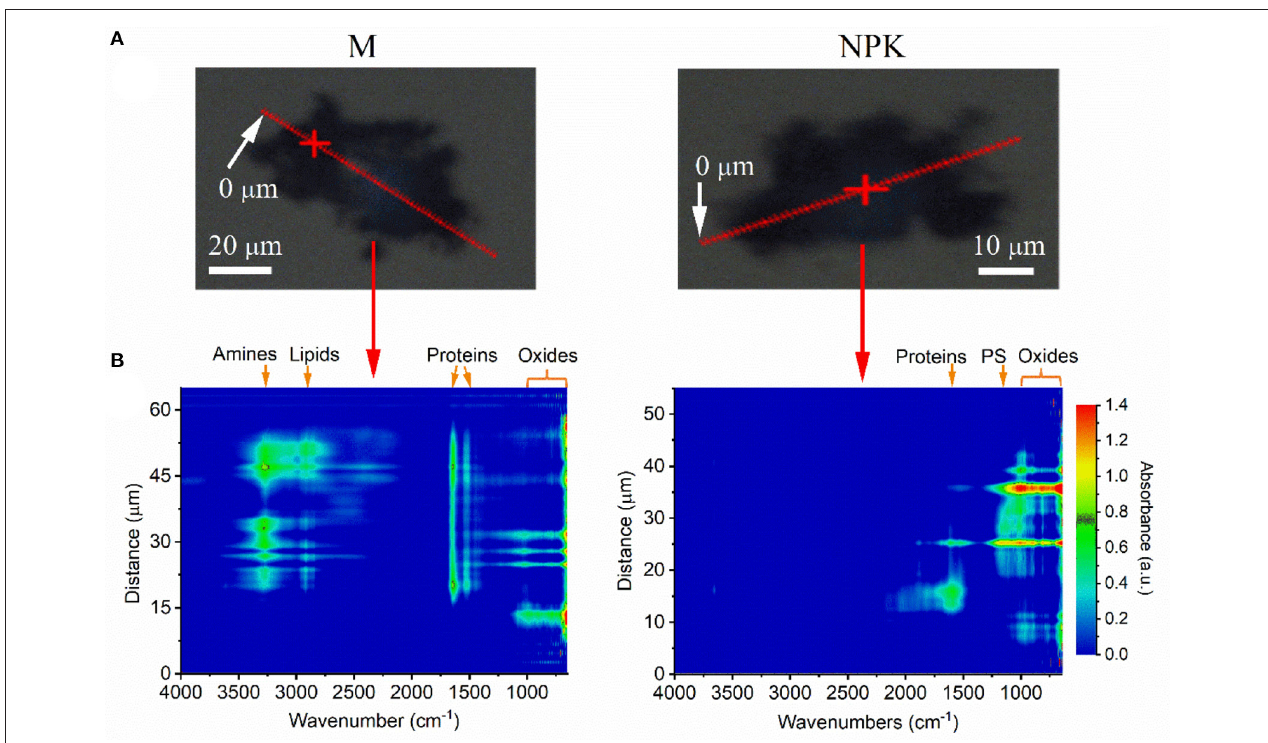
FIGURE 3 | Optical images (A) and the spatial related SR-FTIR spectromicroscopy (B) of soil particles in the contrasting fertilization treatments. M, farmyard manure fertilization, NPK, chemical fertilization. PS, polysaccharides. The µ -FTIR spectra peaks noted with white dashed lines represent the functional groups of N-H stretching of carboxylic acids ( ∼ 3,400–3,200 cm − 1 ), C-H stretching of lipids ( ∼ 2,920 cm − 1 ), aromatic C = C vibrations and amide N-C stretch ( ∼ 1,650 and 1,530 cm − 1 , respectively), and secondary minerals ( < 950 cm − 1 ), respectively. The color is relative for µ -FTIR peak height and does not allow quantitative comparisons between